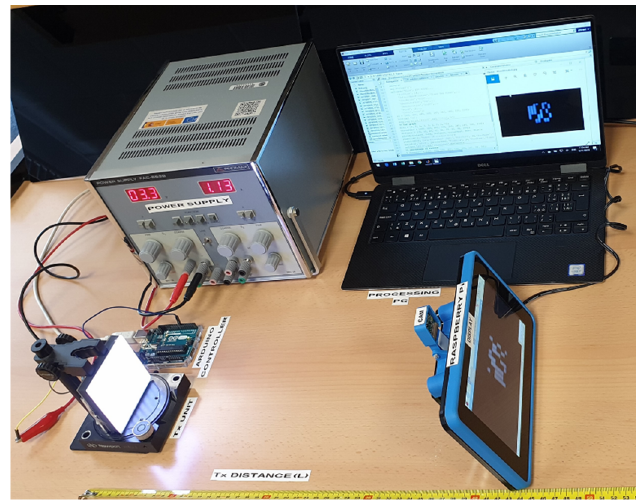
Figure 7. Experiment setup of the MIMO ‐ OCC scheme. Table 2. Key parameters of the experiment setup.